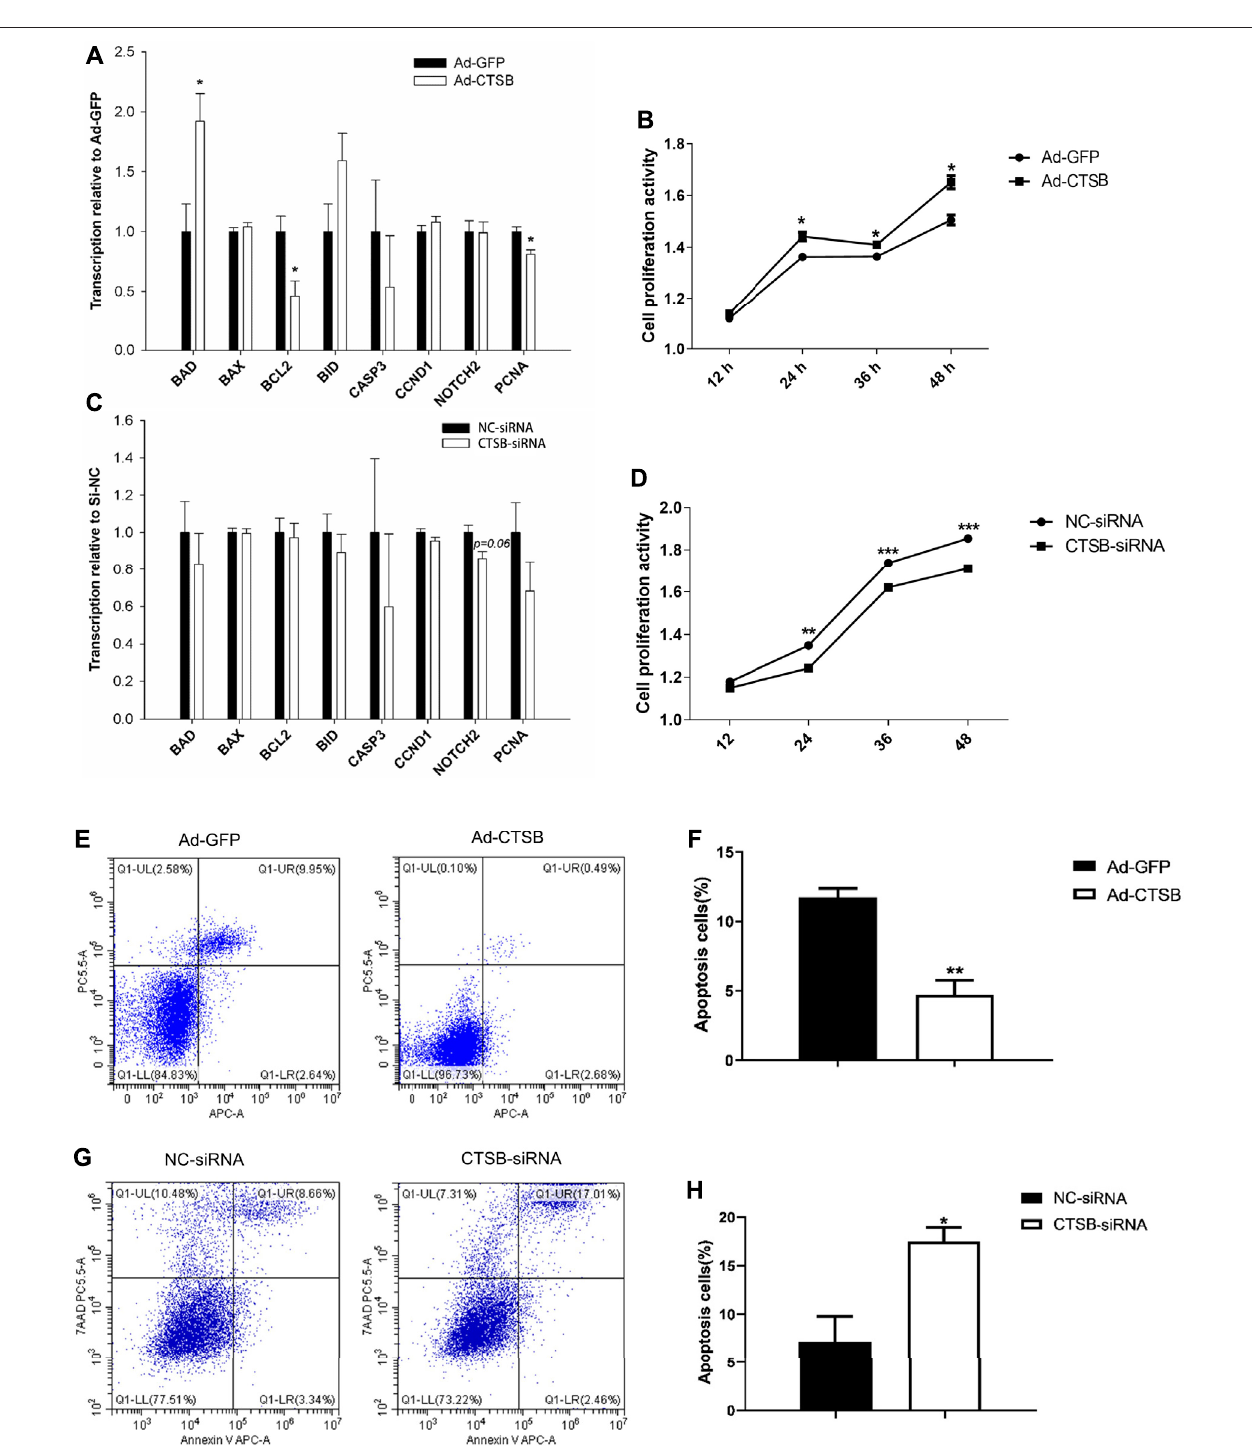
FIGURE 6 | CTSB overexpression and interference on the proliferation and apoptosis of rabbit GCS. Transcription of genes associated with cell proliferation and apoptosis after CTSB overexpression (A) and knockdown (C) . Rabbit GCS proliferation after CTSB overexpression (B) and knockdown (D) . CTSB overexpression decreasedtheapoptosisinGCSasassessedby fl owcytometer (E,F) .CTSBknockdownincreasedapoptosisofGCSasassessedbyusinga fl owcytometer (G,H) .* p < 0.05; ** p < 0.01.